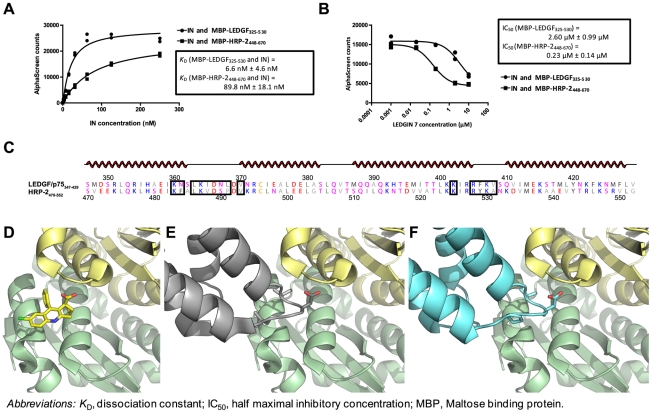
LEDGINs block the interaction of HIV-1 IN with the IBD of either LEDGF/p75 or HRP-2.(A,B) Interactions between His6-tagged IN and MBP-LEDGF325–530 or MBP-HRP-2448–670 were assessed using AlphaScreen technology. (A) 10 nM MBP-LEDGF325–530 (circles) or MBP-HRP-2448–670 (squares) was incubated with various concentrations of IN (2-fold dilutions from 500 to 1.9 nM). Anti-MBP donor and Ni2+-chelate acceptor beads were added and the AlphaScreen signal was read on an EnVision Multilabel reader. Boxed data show average apparent K
D values ± S.E.M. for the IN-MBP-LEDGF325–530 or IN-MBP-HRP-2448–670 interaction as determined from four independent experiments, each performed in duplicate. A representative experiment is shown. (B) MBP-LEDGF325–530 or MBP-HRP-2448–670 (10 nM) was incubated with IN (500 nM) and various concentrations of LEDGIN 7 (10, 2, 0.2, 0.02 and 0 µM, the latter plotted as 0.001 µM). Again, beads were added and the plate was read as described. Boxed data show IC50 values of LEDGIN 7 on the interaction of IN with MBP-LEDGF325–530 or MBP-HRP-2448–670. Average IC50 values ± standard deviations were derived from three independent experiments each performed in duplicate. A representative experiment is shown. In (C–F) the homology of LEDGF/p75IBD and HRP-2IBD and their interaction with IN is shown. (C) Alignment of LEDGF/p75347–429 and HRP-2470–552. Amino acids are colored by type and secondary structure is depicted on top (α-helices in red). Residues involved in the interaction with IN catalytic core domain are boxed. Alignments were generated with ClustalW [63] and further visualized in ALINE [64]. (D–F) Cartoon representations of the IN catalytic core domain (CCD) dimer (pale green and pale yellow) with (D) LEDGIN 6 (sticks, colored by atom), (E) LEDGF/p75IBD (gray) or (F) HRP-2IBD (cyan). Side chains of the crucial amino acids, mimicked by LEDGINs, i.e. residues I365, D366, L368 of LEDGF/p75, and corresponding HRP-2 residues V488, D489 and P491, are shown in sticks colored by atom. Structures of LEDGF/p75IBD in complex with IN CCD dimer were taken from PDB ID: 2B4J [65]. HRP-2IBD homology models were built with MODELLER [66], based upon the same LEDGF/p75IBD – IN CCD dimer structure. The structure of the LEDGIN 6 – IN CCD dimer complex was taken from PDB ID: 3LPU [25]. All structures were visualized in PyMol (DeLano Scientific LLC, Palo Alto, USA).